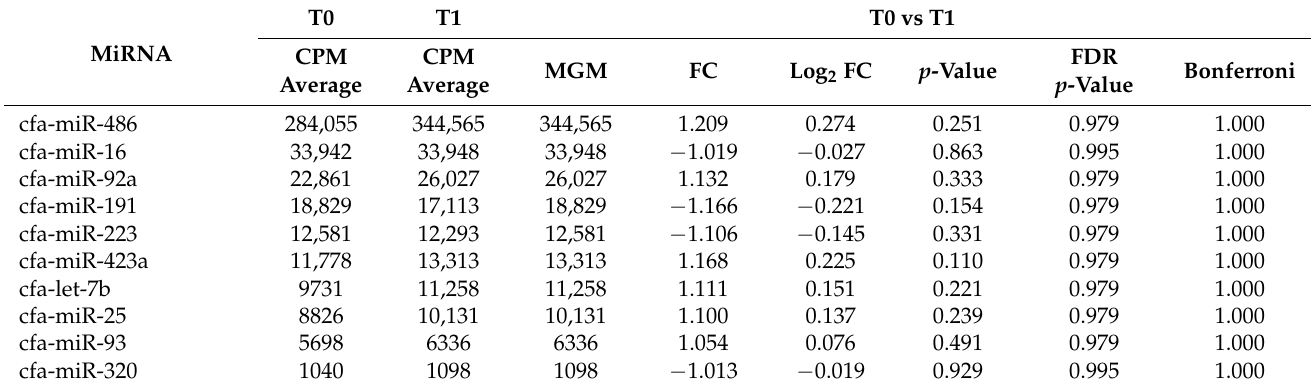
Table 3. Stable EC miRNA. The table reports the NGS results of the dog serum miRNome evaluated at rest (T0) and after physiological stress conditions due to a SAR performance simulation (T1). T0 CPM and T1 CPM columns show the mean values of the miRNAs selected as probable ECs. The T0 vs T1 column shows the values of Max group means (MGM), fold change (FC), Log2 fold change, p -value, FDR p -value, and the results of the Bonferroni